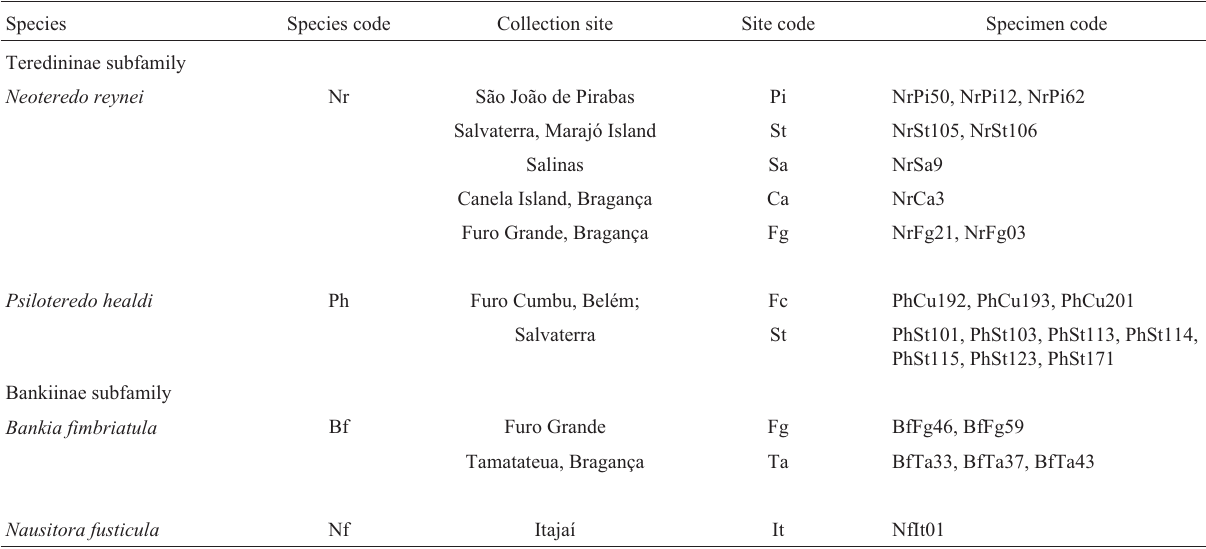
Table 2 - Species, collection sites and specimen codes of the teredinid species used in this study. The Itajaí collection site was in the Brazilian state of Santa Catarina, all the other sites being in Pará state, Brazil.